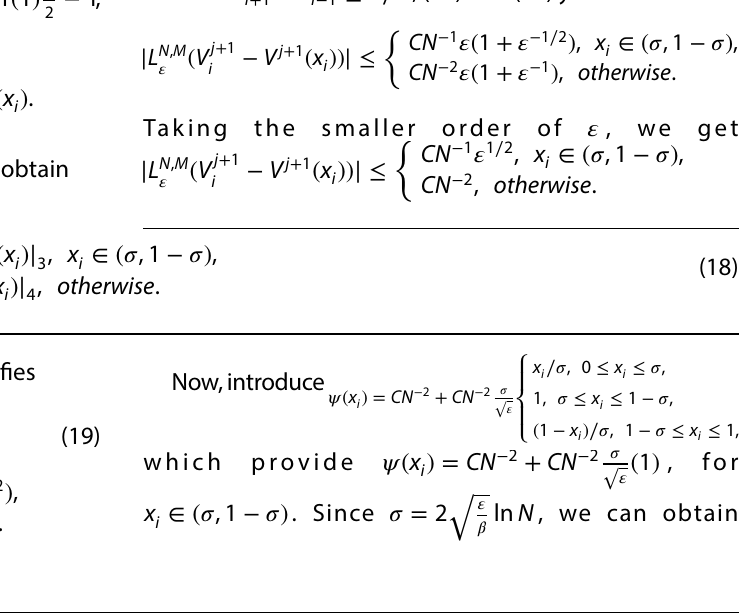
Table 1 E N , M 𝜀 , E N , M and R N , M of Example 1 for 𝛽 = 1 and 𝜃 =